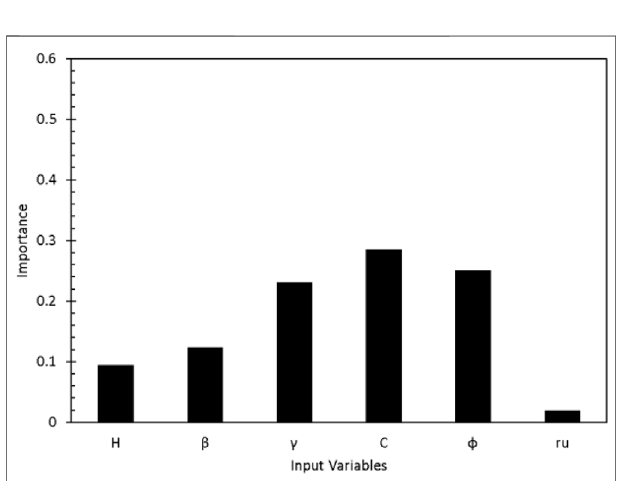
FIGURE 6 | Importance of a Feature for Classi fi cation Variable importance.